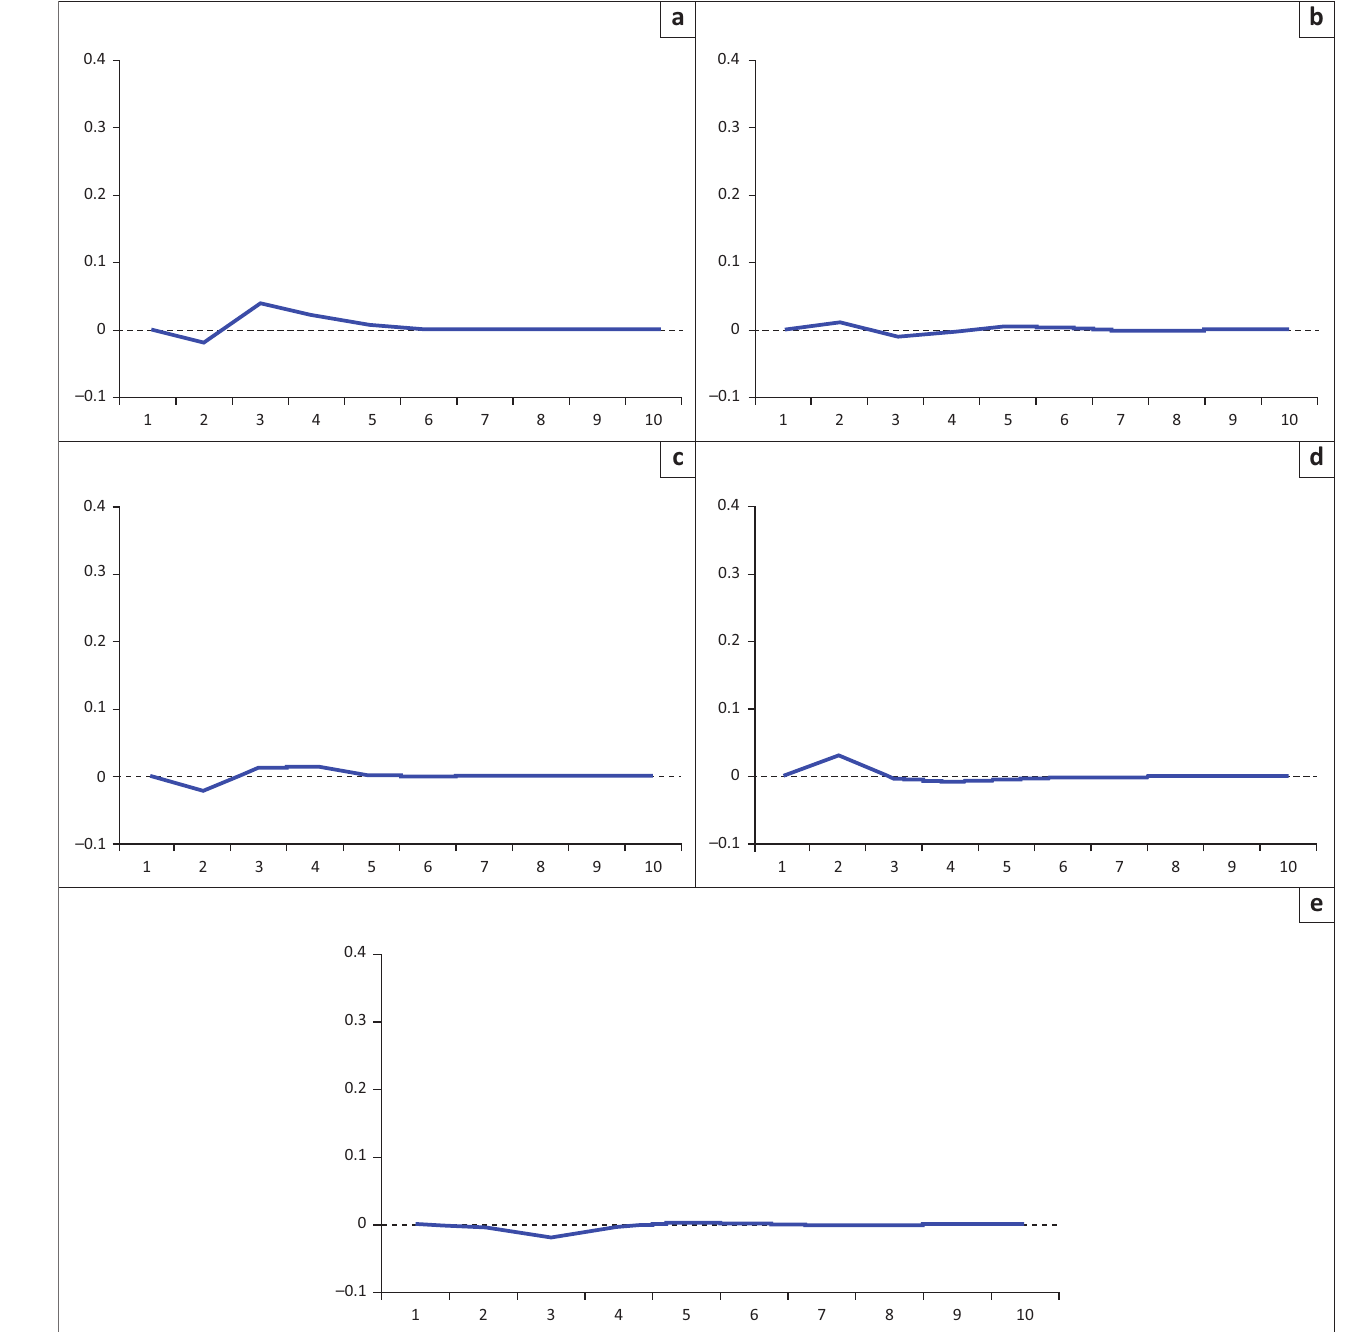
FIGURE 1: Impulse response of South Africa to a shock in each bond market response of South Africa to (a), Germany; (b), Norway; (c), Sweden; (d), United Kingdom and (e), United States of